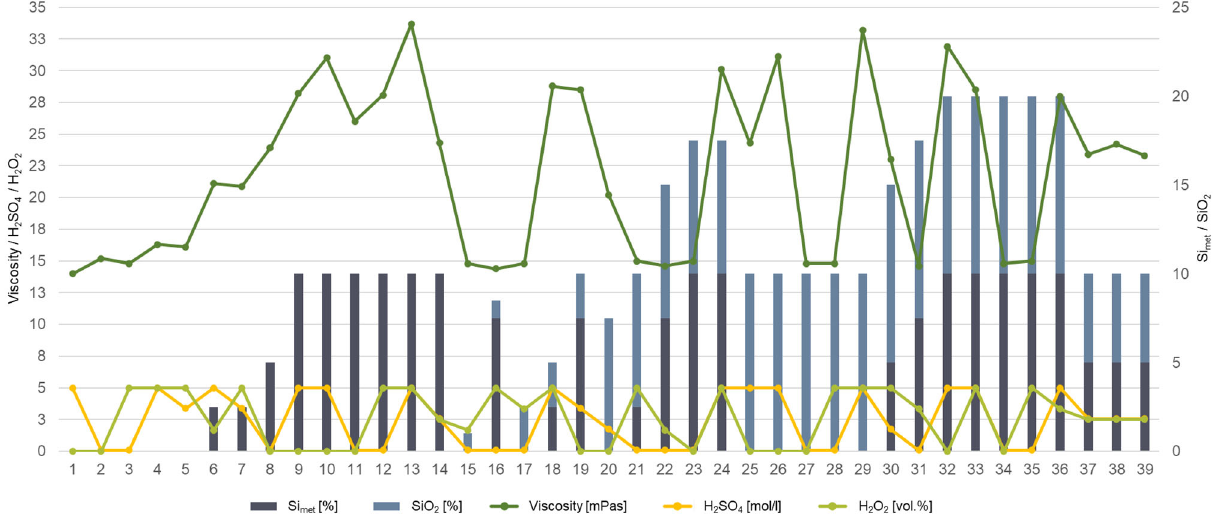
Figure 4. Results of the viscosity [mPas] determination of solutions 1 to 39 as a function of H 2 SO 4 [mol/L] and H 2 O 2 [vol.-%] concentration as well as the amount of SiO 2 and Si met [mass-% of black mass] added to the solution.